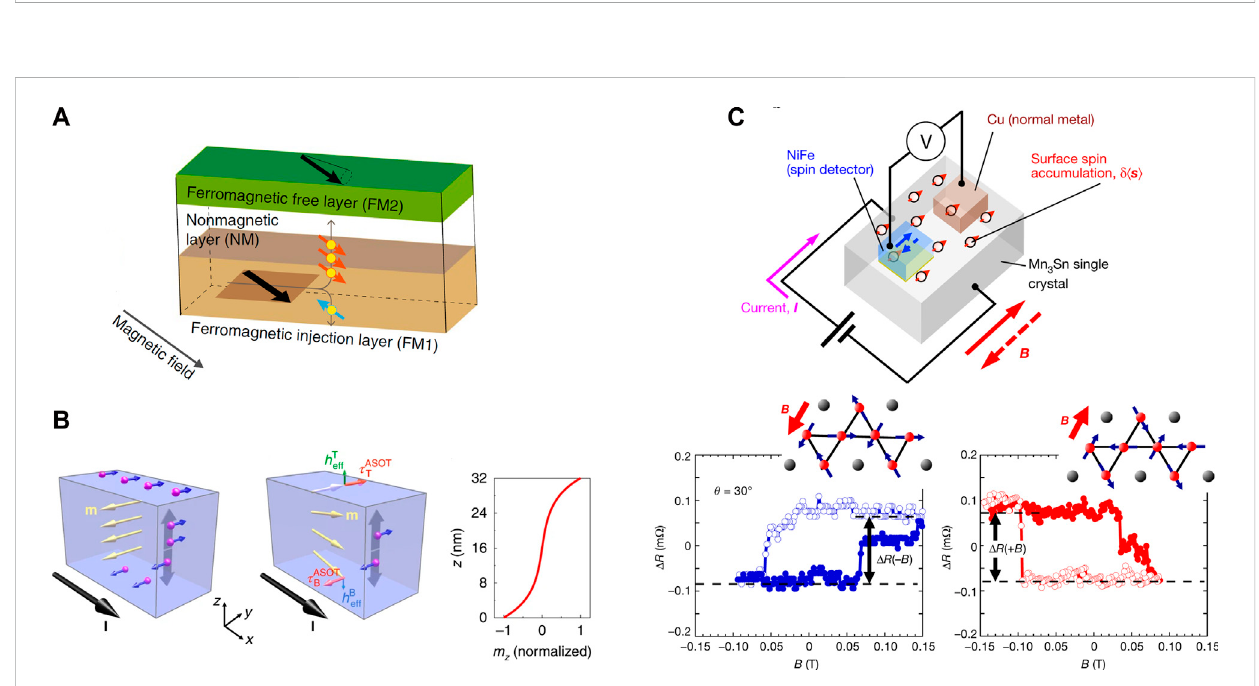
FIGURE 4 Emergence of SCCs due to time-reversal symmetry breaking. (A) Spin-AHE in ferromagnetic metal (FM)1/non-magnetic metal (NM)/FM2 tri-layer structure magnetic damping constant in FM2 is modulated by SOT due to spin-AHE in FM1 in [74]. (B) Tilting spin polarization vector about the magnetic moment in ferromagnetic metal in [76]. (C) Spin accumulation in the non-collinear antiferromagnet Mn 3 Sn due to magnetic SHE in [79]. The chemical potential measurement detects the current-induced spin accumulation via a voltage drop across NiFe and Cu electrodes. Polarity changes of the magnetoresistance loop indicate the sign change of the accumulated spin polarization